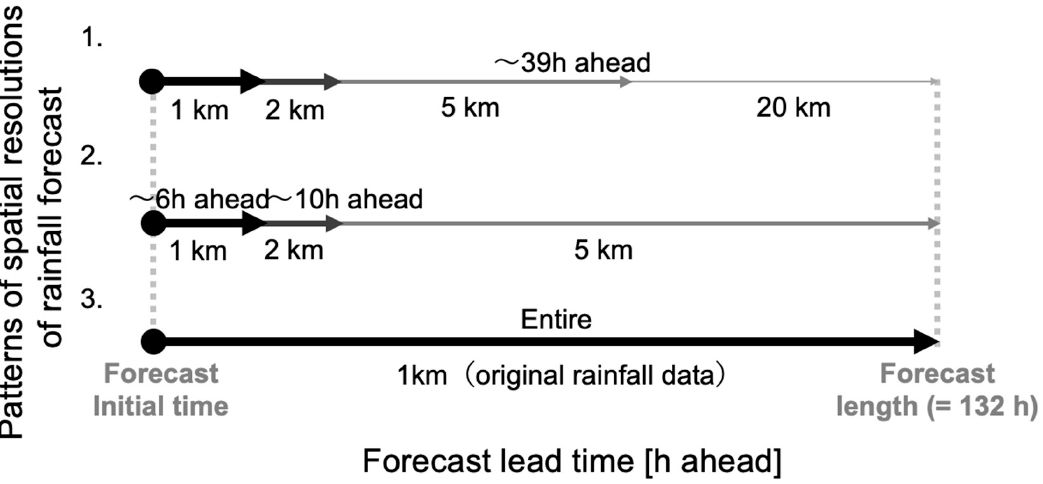
Figure 8. Forecast pa tt erns of spatial resolutions according to forecast-lead